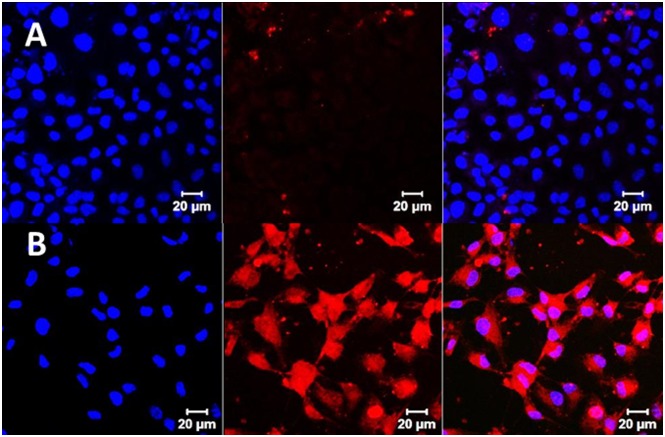
Cell uptake study of HA micelle labeled with Flamma™552 dye by confocal microscopy.
A. Representative picture of FL83B cells incubated in 70 μg/ml of HA micelle labeled with Flamma™552. Accumulation of HA micelle labeled with Flamma™552 in FL83B cells was found to be minimal; B. Representative picture of hHSC cells incubated with 70 μg/ml of HA micelle labeled with Flamma™552. HA micelle labeled with Flamma™552 is clearly seen in HSC with more fluorescent intensity than FL83B. The incubation period was 2 hours for all experiments. Blue color represent uptake of DAPI stain in nucleus.